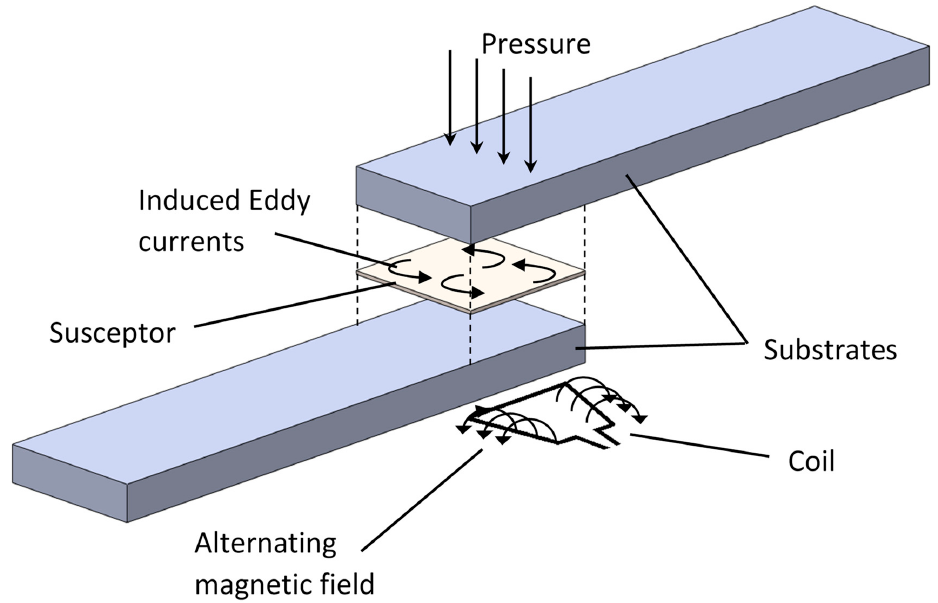
Figure 10. Schematic representation of induction welding process.